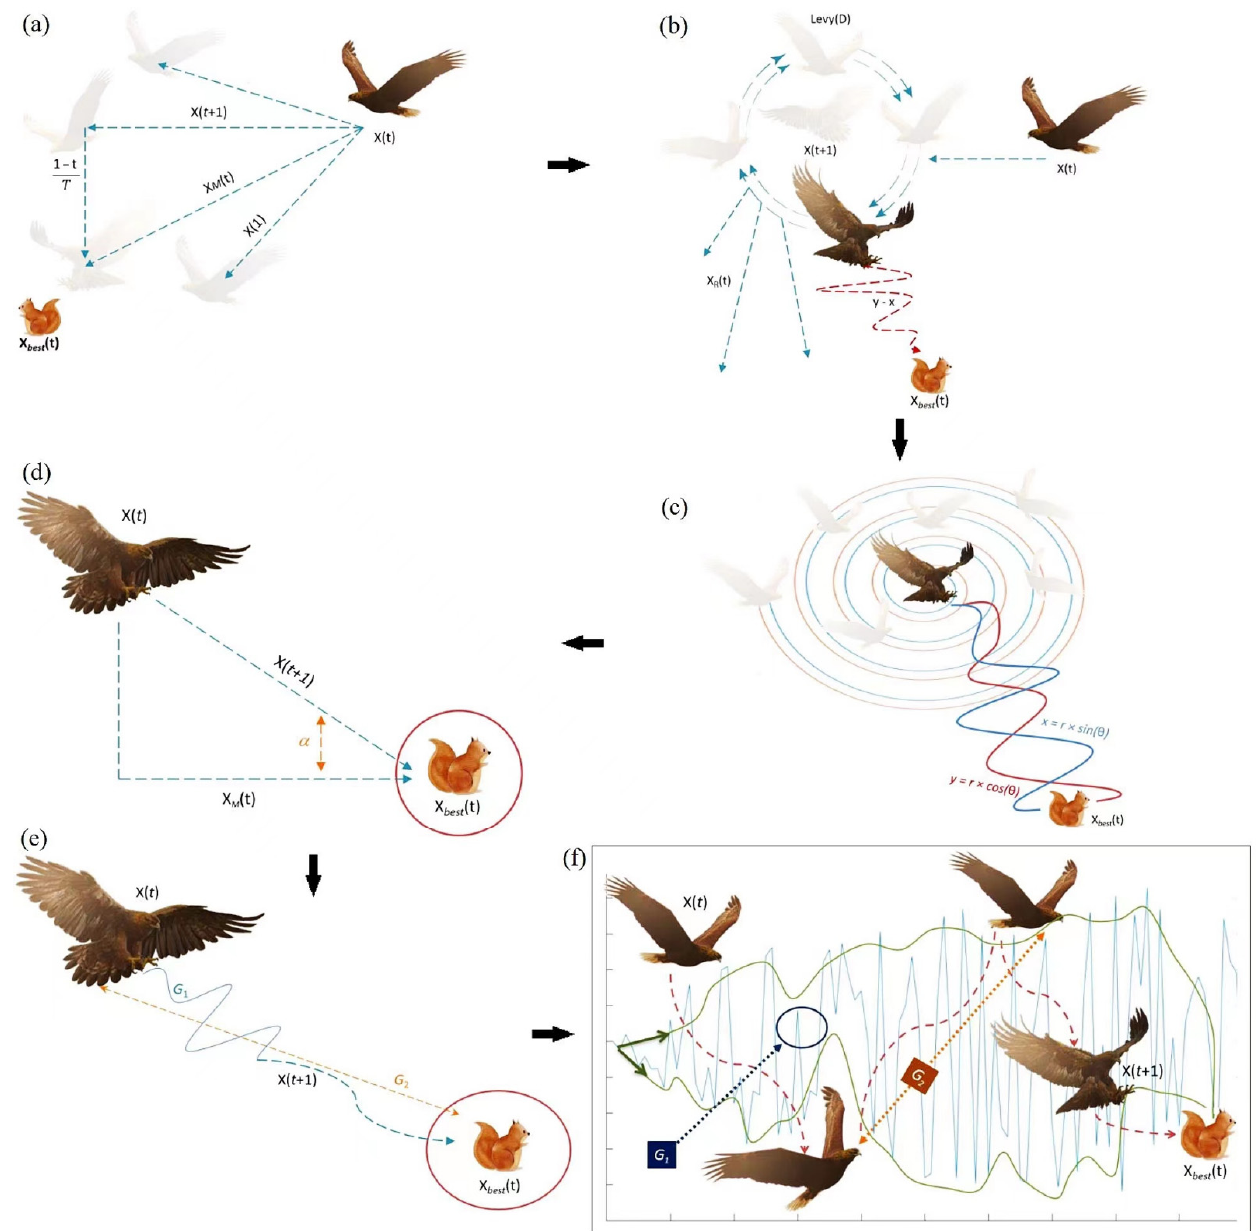
Figure 11. The influence of the principles and parameters of each step of the aquila optimizer algorithm on AO: ( a ) expanded exploration; ( b ) narrowed exploration; ( c ) expanded exploitation; ( d ) narrowed exploitation; ( e ) narrowed exploitation; ( f ) the effects of the quality function ( QF ), G1 and G2 on the behavior of the AO [30,31].